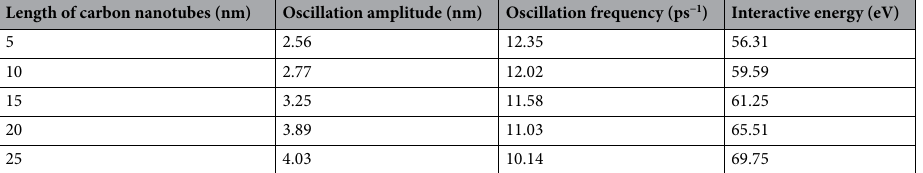
Table 2. Highest values of interactive energy, oscillation frequency and oscillation amplitude of carbon nanotubes (7 and 7) in terms of carbon nanotube length in the last step of molecular dynamics simulation.